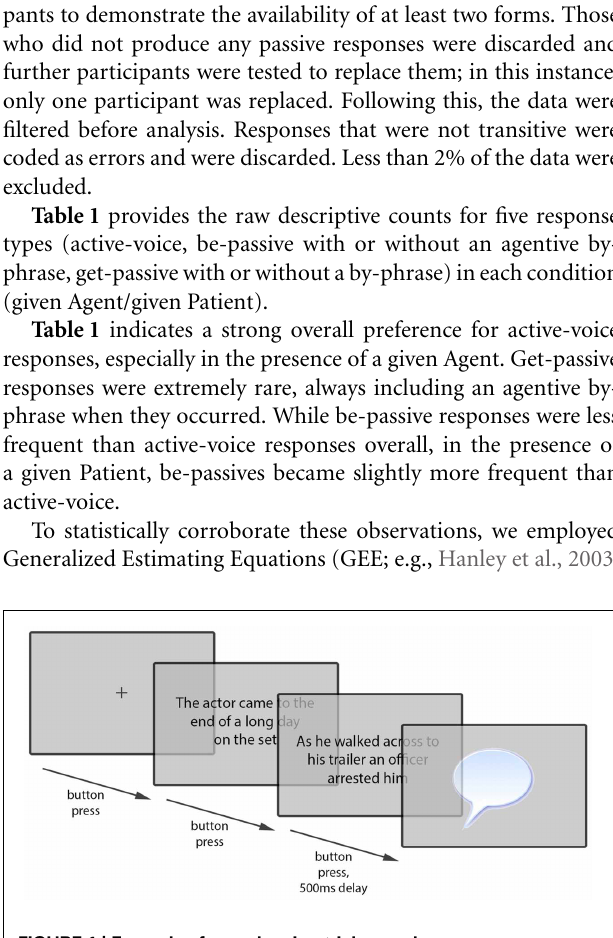
FIGURE 1 | Example of paraphrasing trial